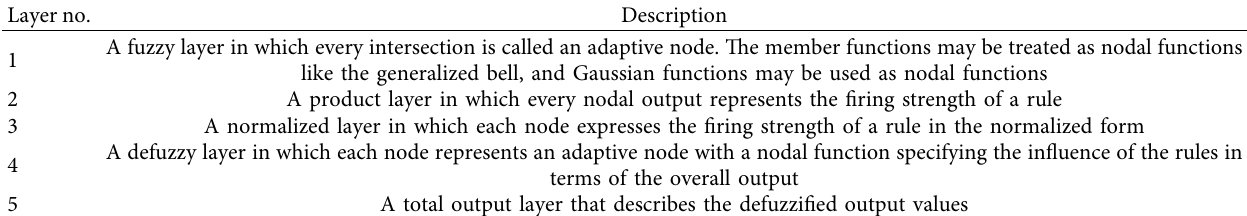
Table 5: Structural layers of ANFIS.